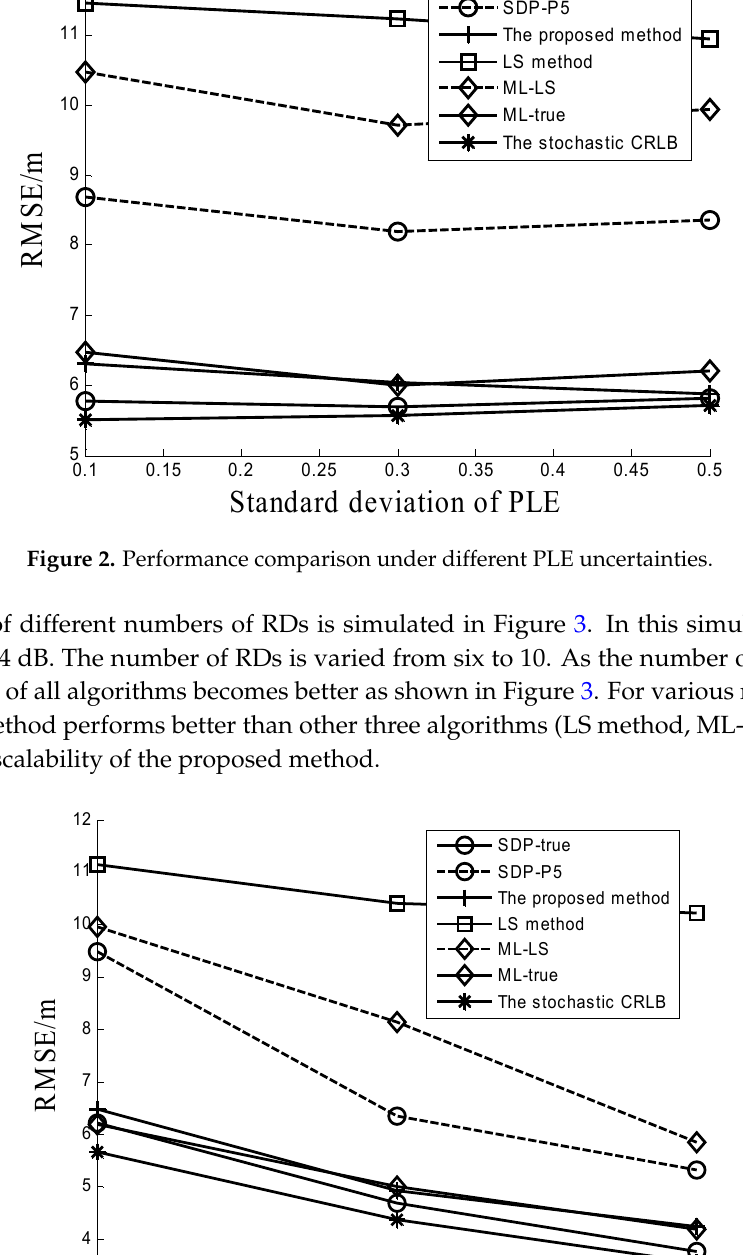
Figure 4. Comparison among the proposed stochastic CRLB, the deterministic CRLB, and the theoretical variance of the proposed method under different RSS noises.